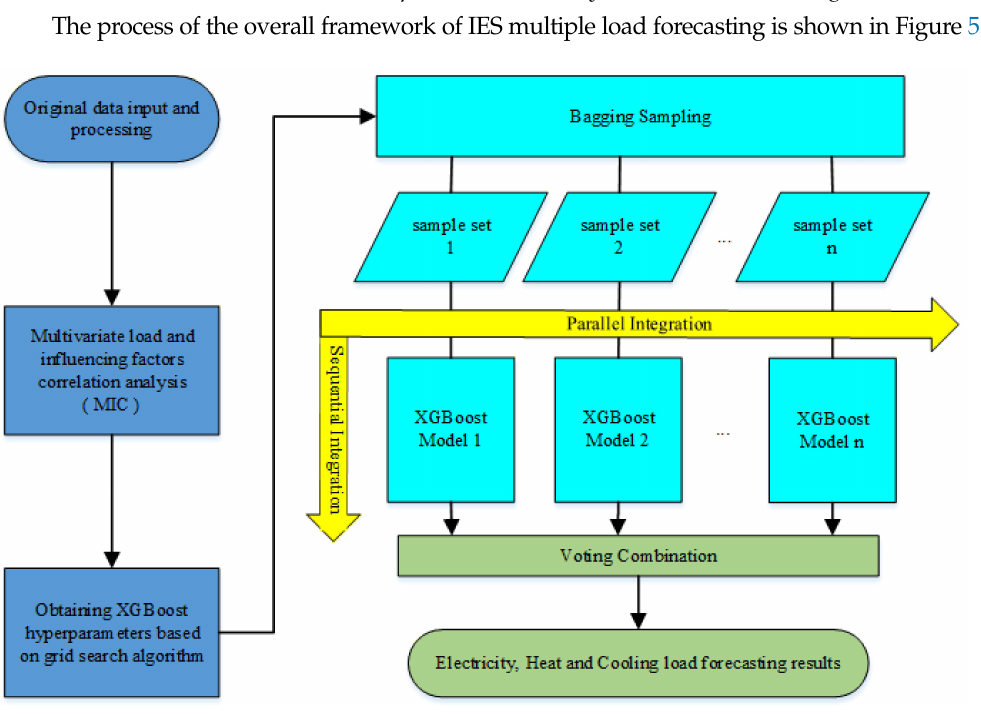
Figure 5. Multivariate load forecasting based on sequential-parallel hybrid ensemble